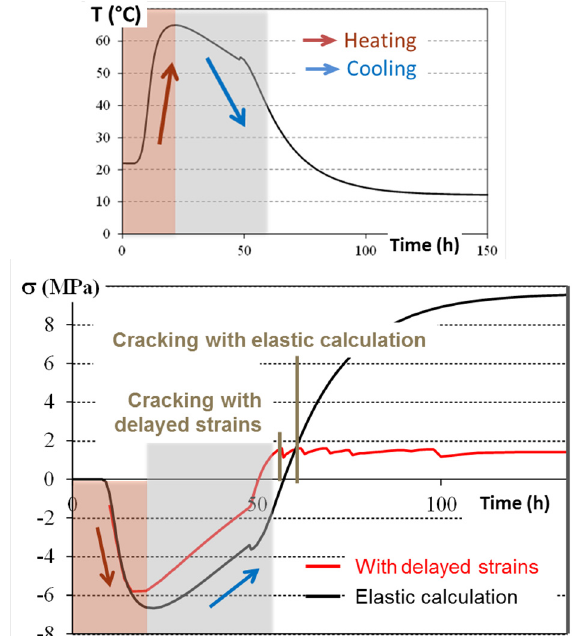
Figure 8. Effect of delayed strain consideration in the calculation of the stress and cracking risk of a restrained concrete tie at early